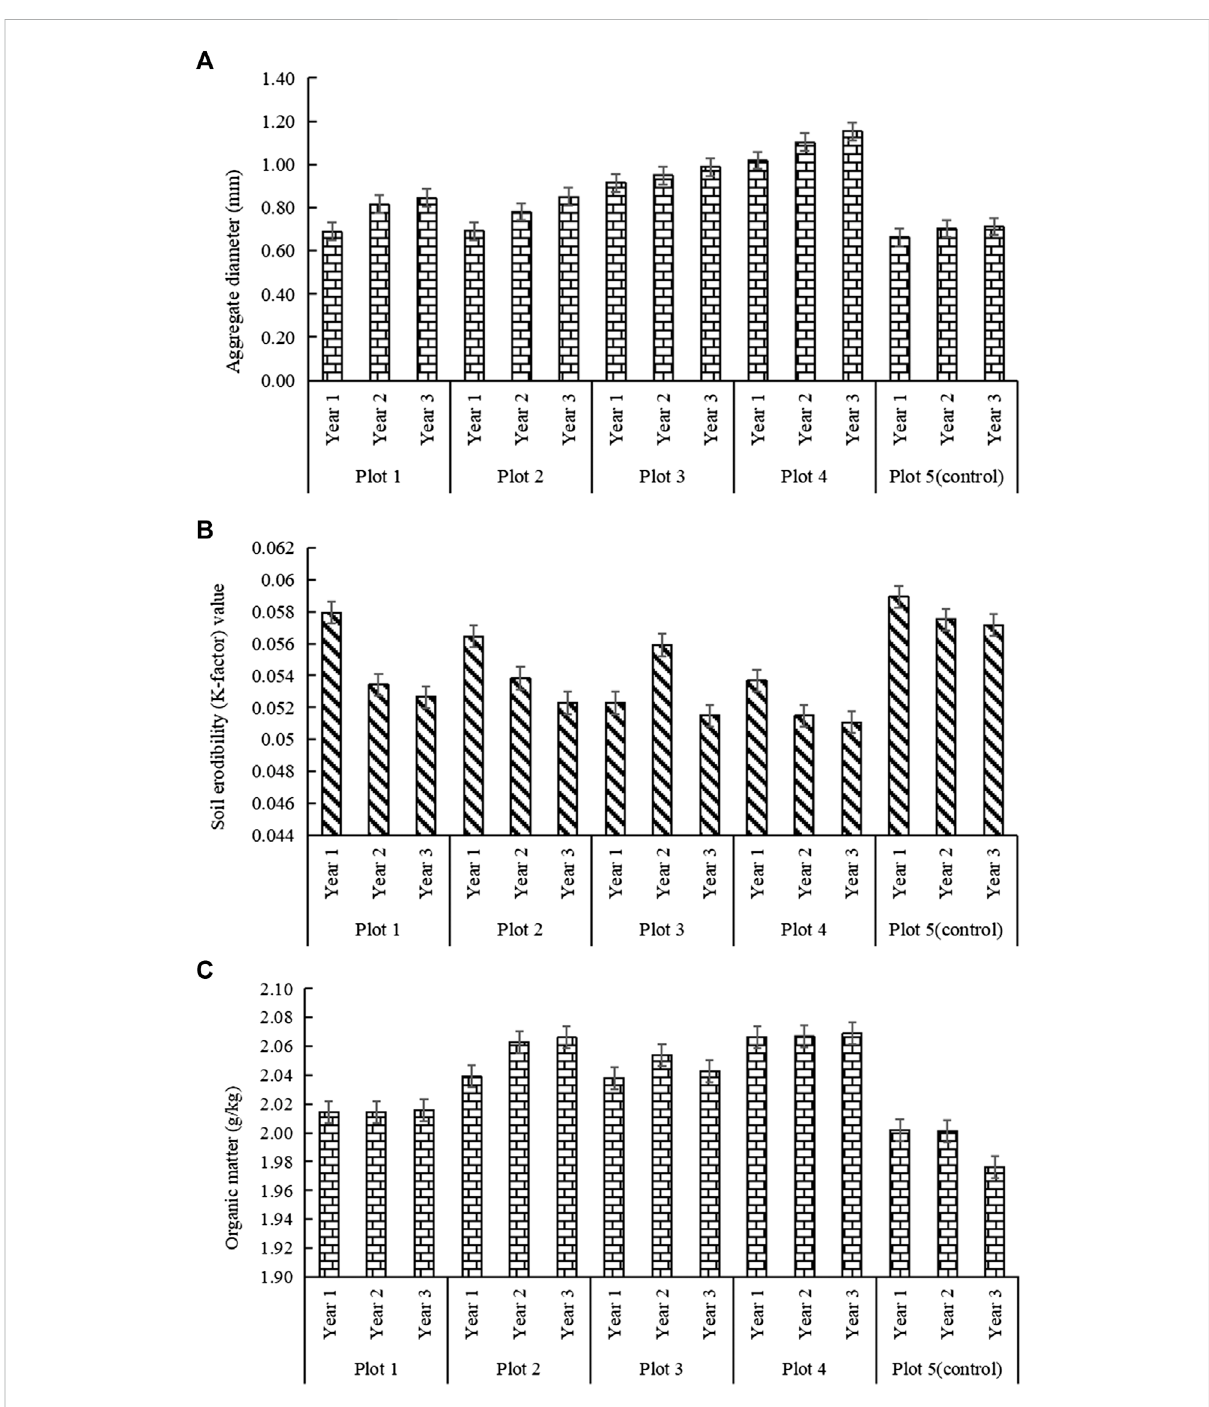
FIGURE 4 (A) Changesinmeanweightdiameter(MWD)ofthesoilaggregatesinthefourplotscorrespondingtodifferentmicrotopographymodi fi cations. (B) Changes in soil erodibility in the plots corresponding to different microtopography modi fi cations. (C) Changes in organic matter in the plots corresponding to different microtopography modi fi